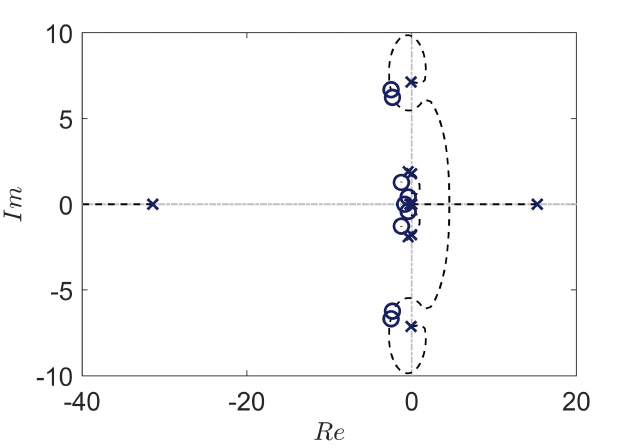
Figure 9. Root locus of the ˜ P